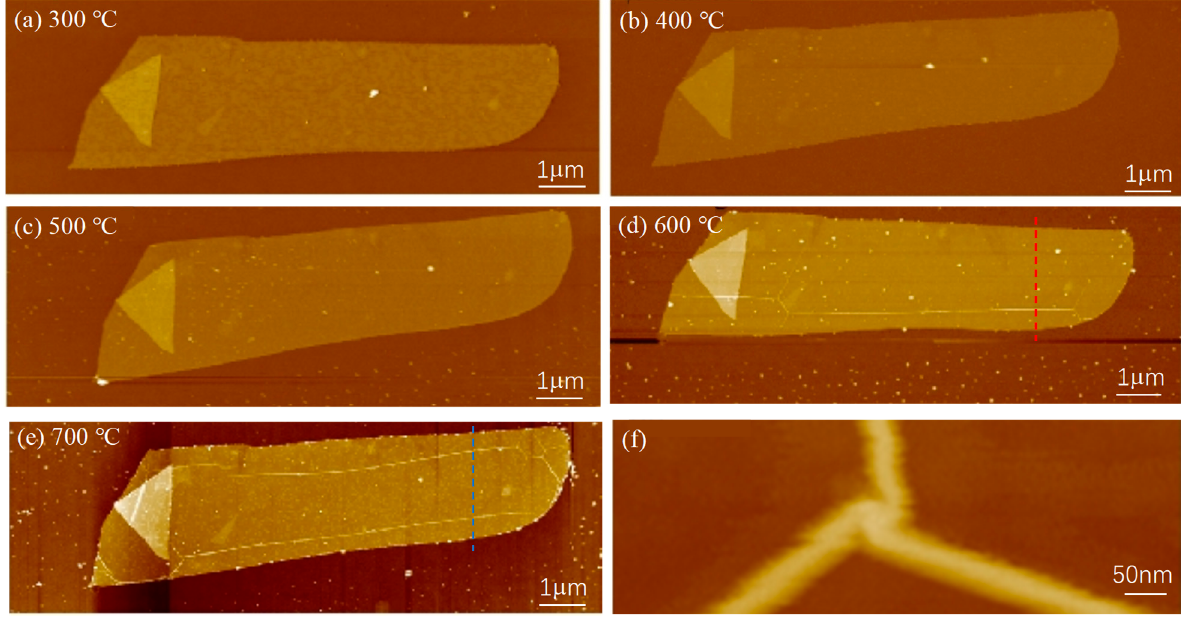
Figure 6. The morphology of the sample after annealing at 300 °C ( a ), 400 °C ( b ), 500 °C ( c ), 600 °C ( d ) and 700 °C ( e ). ( f ) The morphology of the junction of the wrinkles. Although the wrinkles after annealing occurred under both 600 °C and 700 °C, their number and location changed. Two long wrinkles were observed under 700 °C, and only one long wrinkle appeared under 600 °C. The number of wrinkles grows along with the annealing temperature, suggesting that more compressive strain has been introduced. In order to verify our suspicions, the heights along the red dashed line in Figure 6d and along the blue dashed line in Figure 6e were measured, as shown in Figure 7. The wrinkle heights after annealing under 600 °C and 700 °C were approximately 6 nm and 10 nm relative to the flat sample surface. Although the winkles after annealing under 700 °C were lower than those that appeared under 600 °C, the strain corresponding to two wrinkles was greater than one wrinkle. Although there were less wrinkles at 700 °C than at 600 °C, there were more wrinkles to withstand the compressive stress at 700 °C.